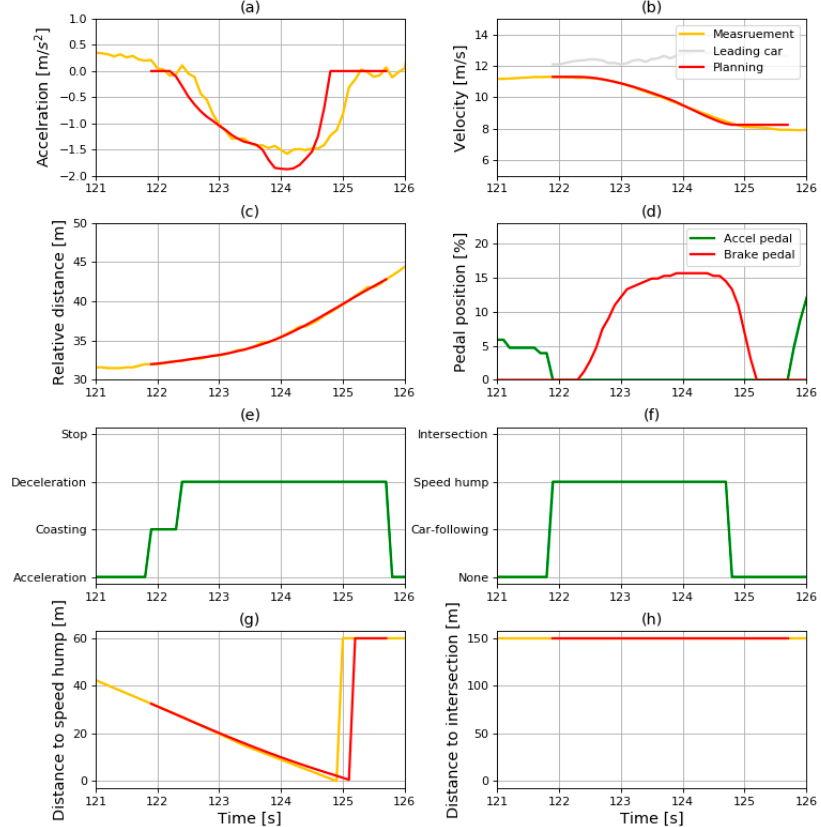
Figure 18. Sliced results of ( a ) acceleration; ( b ) velocity; ( c ) relative distance; ( d ) pedal position; ( e ) driving state; ( f ) deceleration condition; ( g ) distance to speed hump; ( h ) and distance to intersection in speed bump condition.